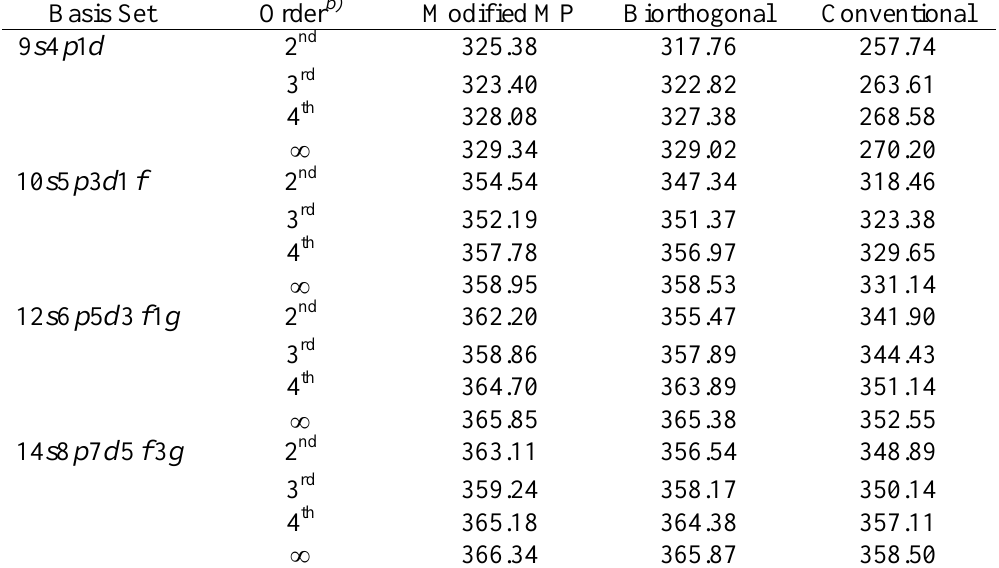
Table I. Basis set dependence of the correlation energies of water a) Basis Set